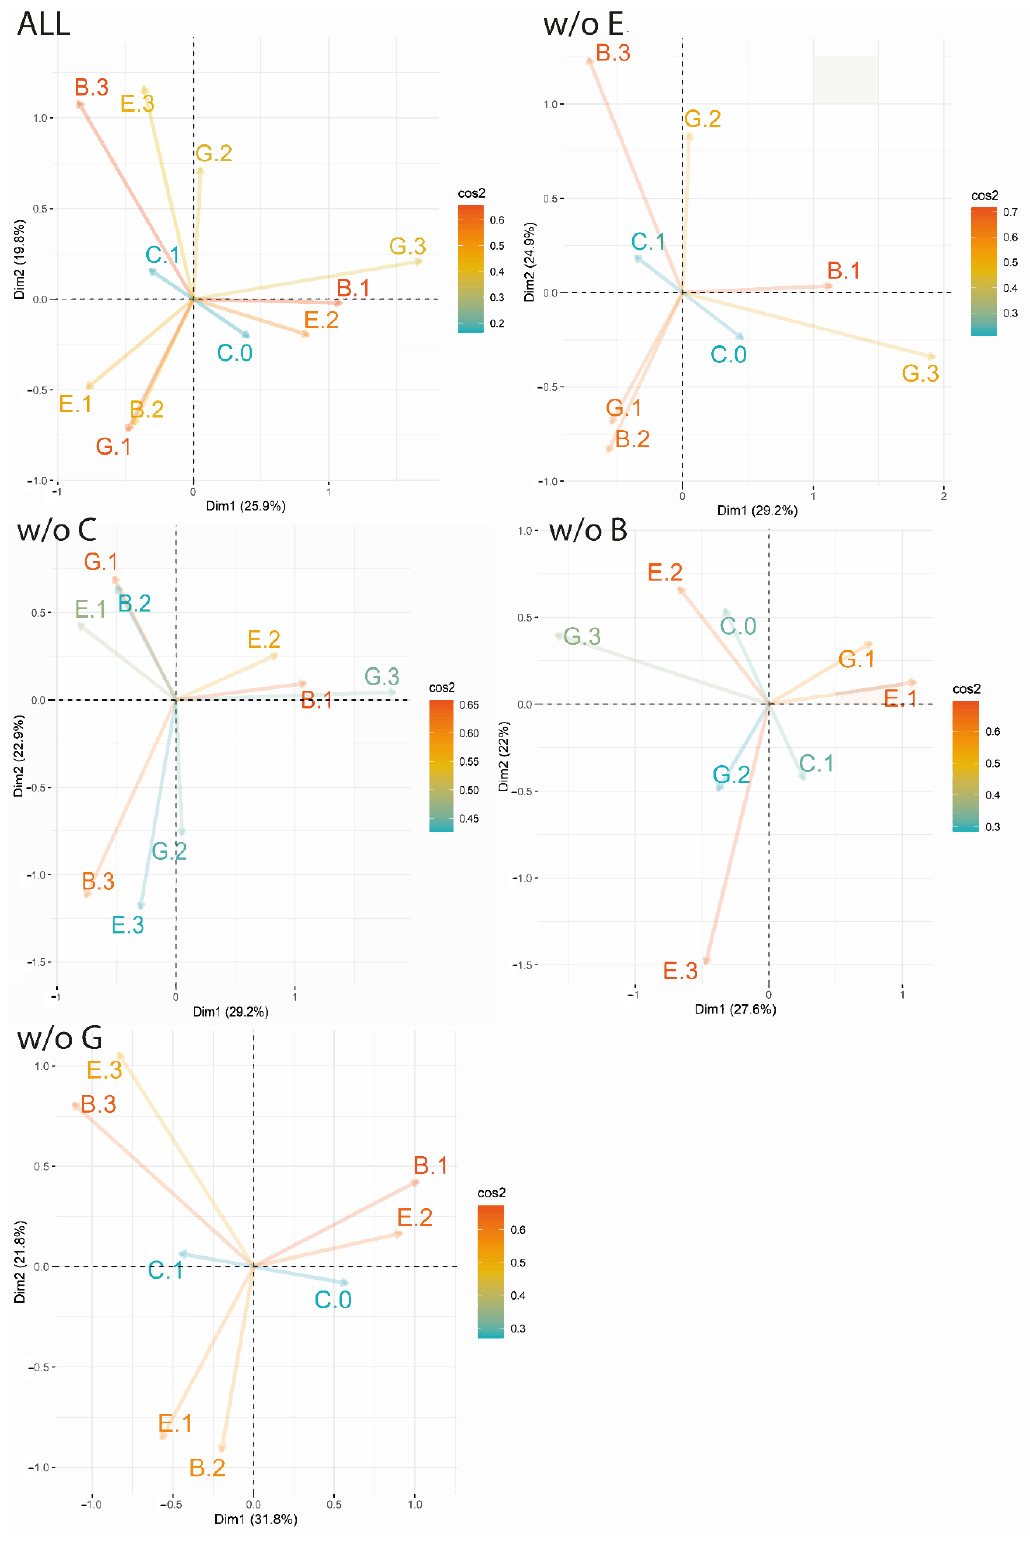
Figure A4 . Graphic representation of the variables in the five MCAs coloured by their quality of representation: the main MCA with all variables ( ALL ), the one without “STRs” ( w/o E ), “Sex marker” ( w/o C ), “Samples per individual per year” ( w/o B ), and “Number of types of sample” ( w/o G ).